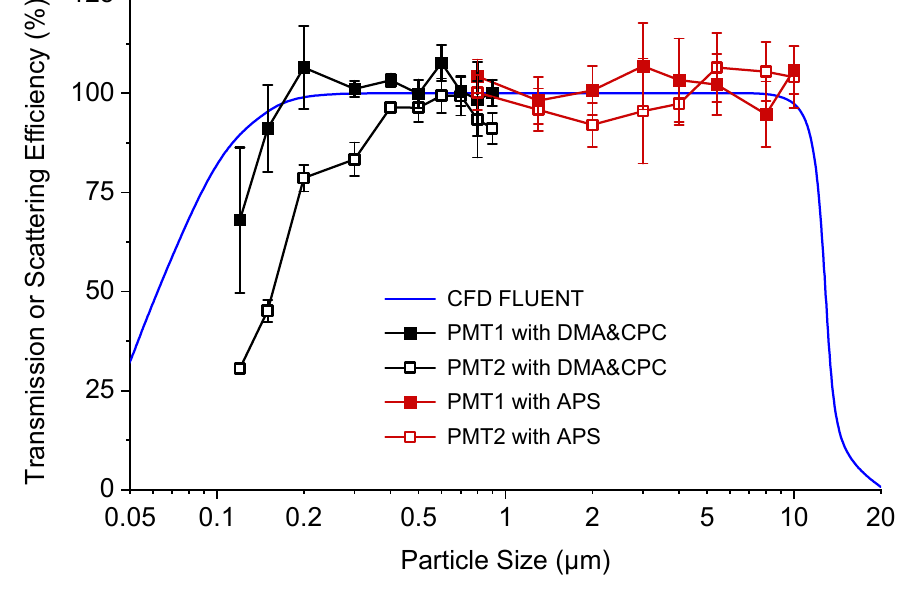
Figure 5. The comparison of the theoretical transmission efficiency and the experimental scattering efficiency of the designed aerosol inlet system.